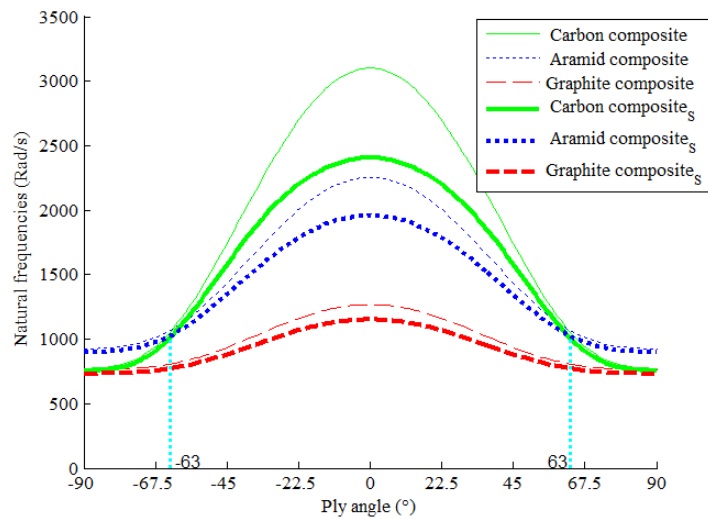
ff erent composite